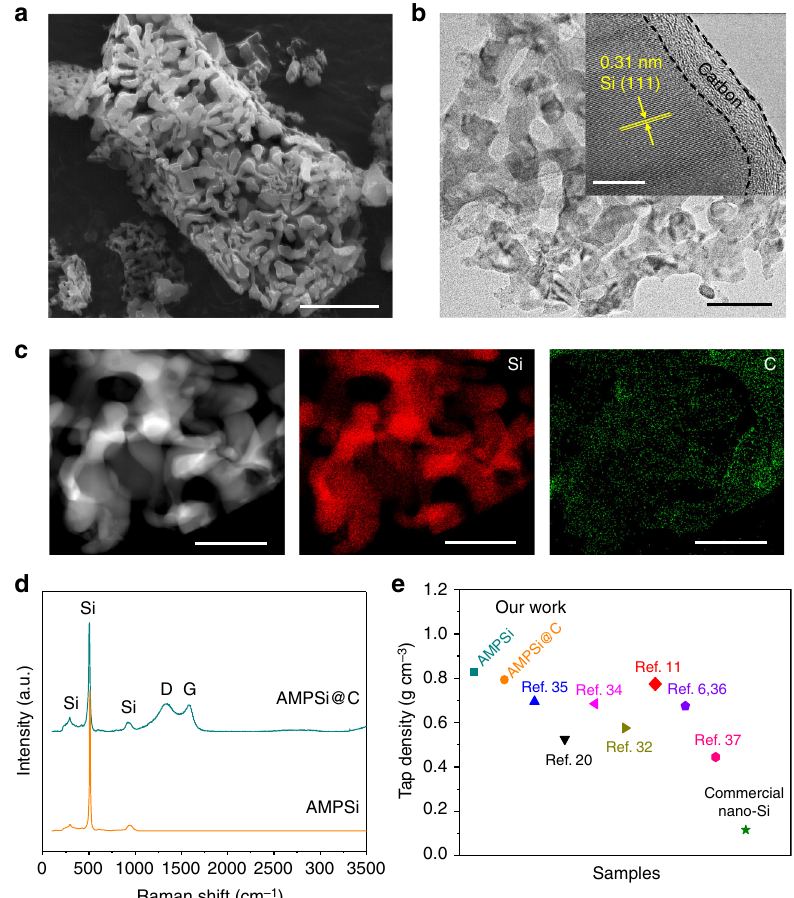
Fig. 3 Characterization of AMPSi@C. a SEM image of AMPSi@C (scale bar = 2 μ m). b TEM image of AMPSi@C (scale bar = 100 nm). The inset (scale bar = 10 nm) is the HR-TEM image showing that the 5 – 8 nm thickness amorphous C shell is coated on the Si nanoligaments and the lattice distance of 0.31 nm corresponds to the d -spacing of the (111) planes of crystalline Si (111). c EDS maps of the Si frameworks in AMPSi@C with red and green corresponding to Si and C, respectively (scale bar for c = 200 nm). d Raman scattering spectra of AMPSi and AMPSi@C. e Comparison of the tap densities between our Si anodes and other Si-based anode materials (see Supplementary Table